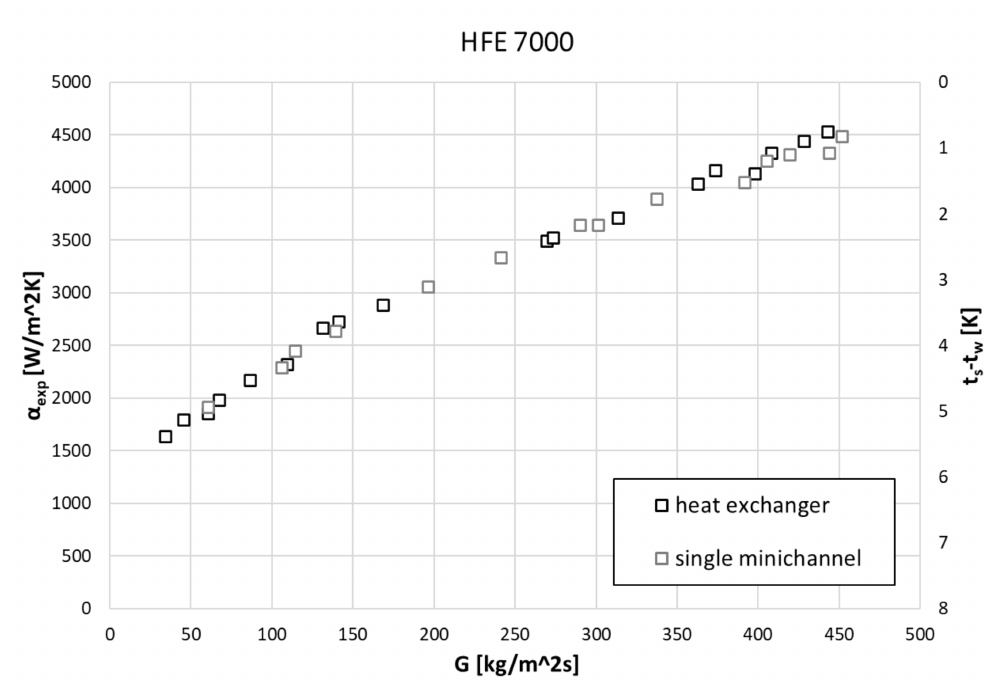
Figure 12. Experimental data for HFE 7000 in the form of correlation between the heat transfer coefficient α , mass flux density G, and temperature difference t s − t w .